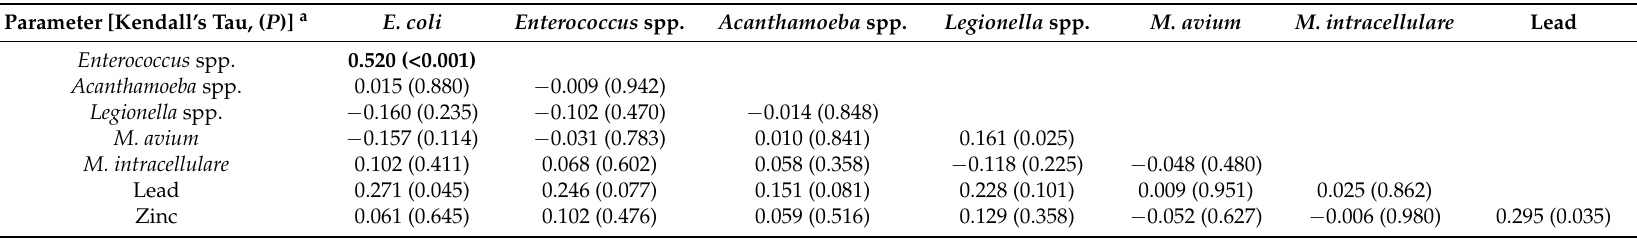
Table 3. Correlations between opportunistic pathogens and fecal indicators in RHRB. FIB correlations shown are for 2016 data only. Parameters with fewer than 5 positive detections were excluded. Significant values are bold-faced, with α corrected = 0.05/7 = 0.007.